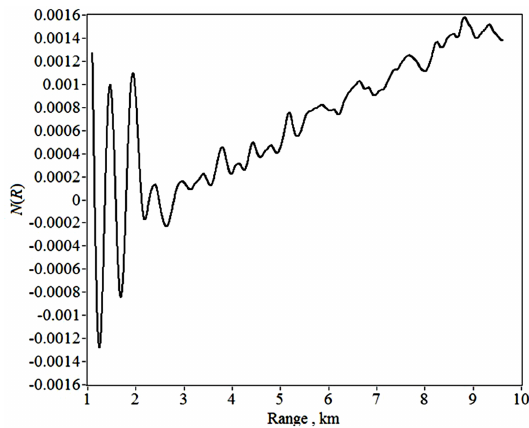
Figure 3. Function N(R)